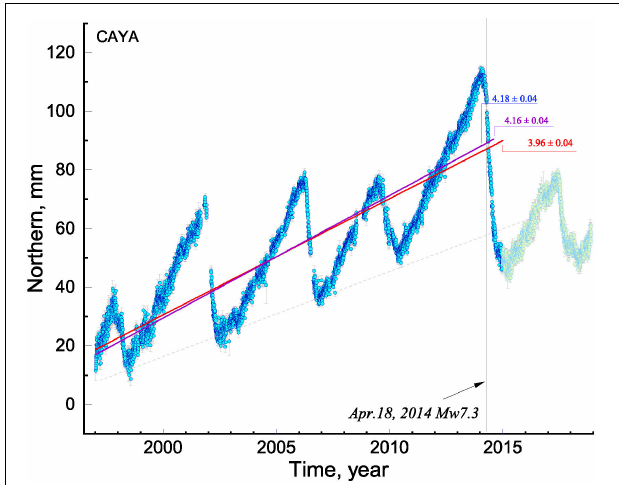
FIGURE 2 | Example of few linear fits to the CAYA northern time series. The resulting estimate of V SN value depends on the selected time interval. To eliminate the impact of the Papanoa Mw 7.3 earthquake the fitting window closes just before the earthquakes